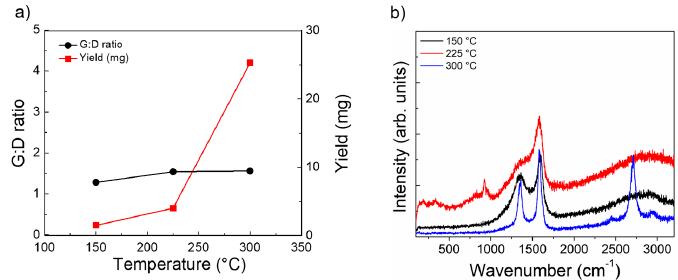
Figure 3. Plot of the Raman G:D ratio (black) and product yield (red) for DLICVD experiments with variable aspiration temperature ( a ) with the corresponding Raman spectra ( b ). Experiments were performed with a reaction temperature of 800 °C, a 1 mL/h injection rate, a 1.25 wt.% catalyst concentration, using EtOH as a carbon source.